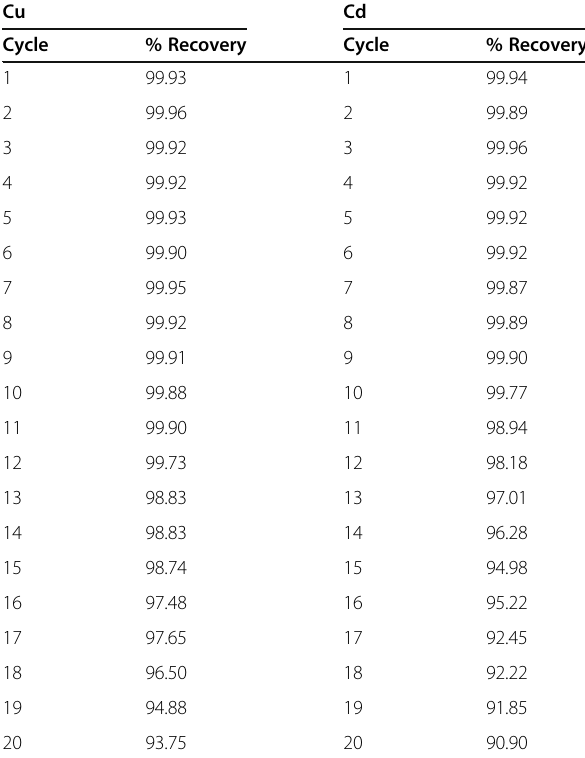
Table 4 Recovery values of Cu(II) and Cd(II) metal ions for the reusability study of the